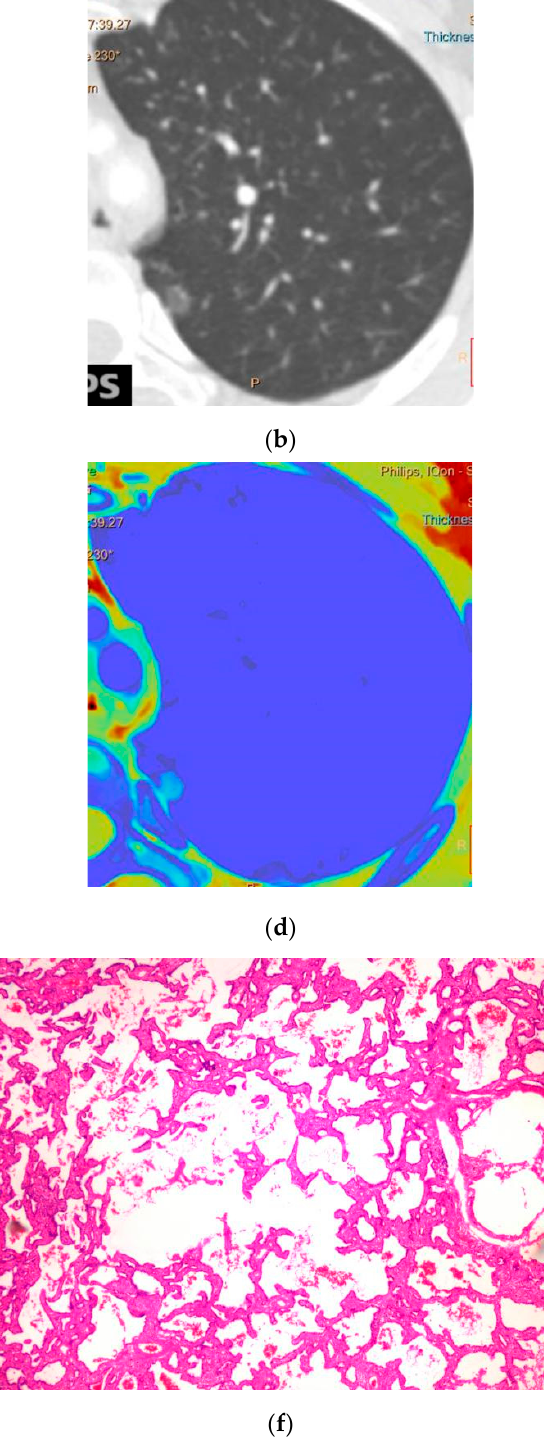
Figure 2. ( a ) CT40 keV, ( b ) CT100 keV, ( c ) iodine density map, ( d ) effective atomic number, and ( e ) electron density in the arterial phase. Spectral dual-layer detector-based computed tomography of a 43-year-old woman showing pGGN in the left upper lobe of lung, Daverage = 8.95 mm, CT40 keVa = − 410.5, CT100 keVa = − 548.7, IC (a) = 1.86, Zeff (a) = 9.37, and EDW (a) = 41.2. The postoperative pathology is adenocarcinoma in situ ( f ).